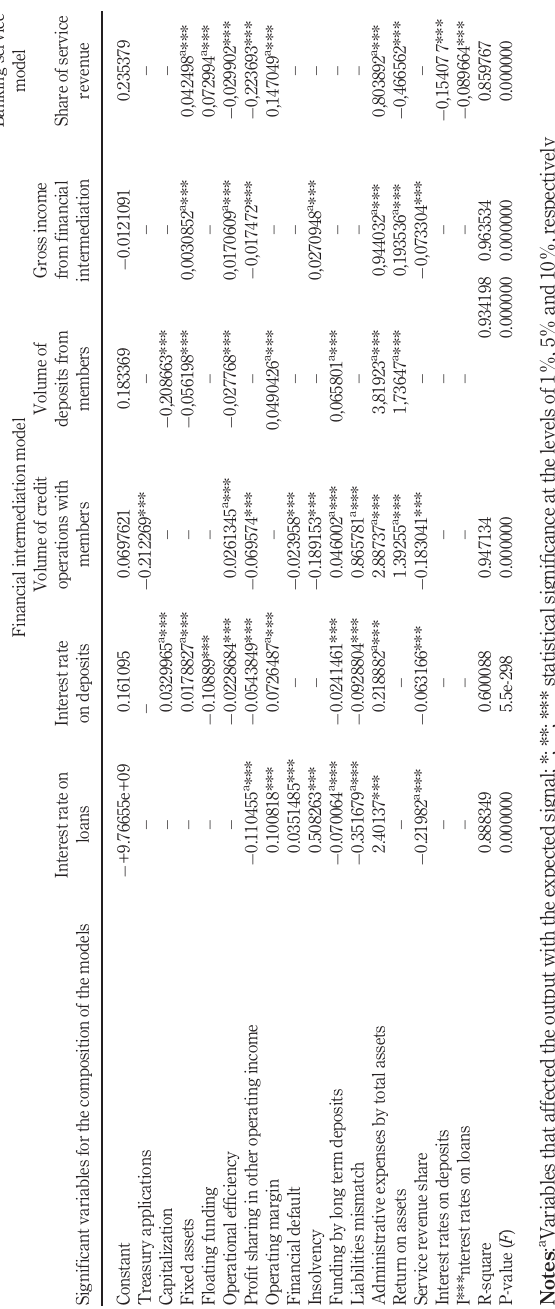
Table 4. Results of regressions with panel